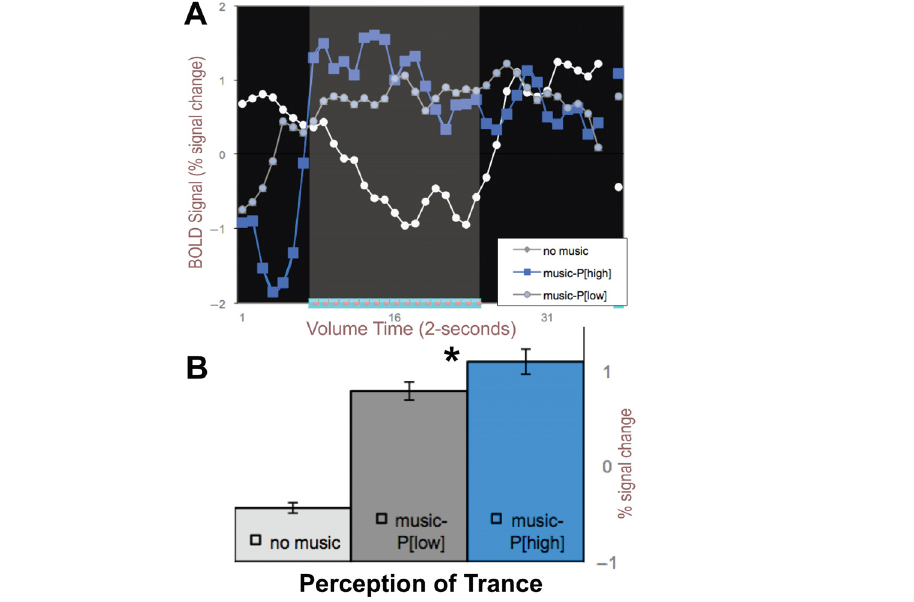
Brain Sci. 2021 , 11 , x FOR PEER REVIEW